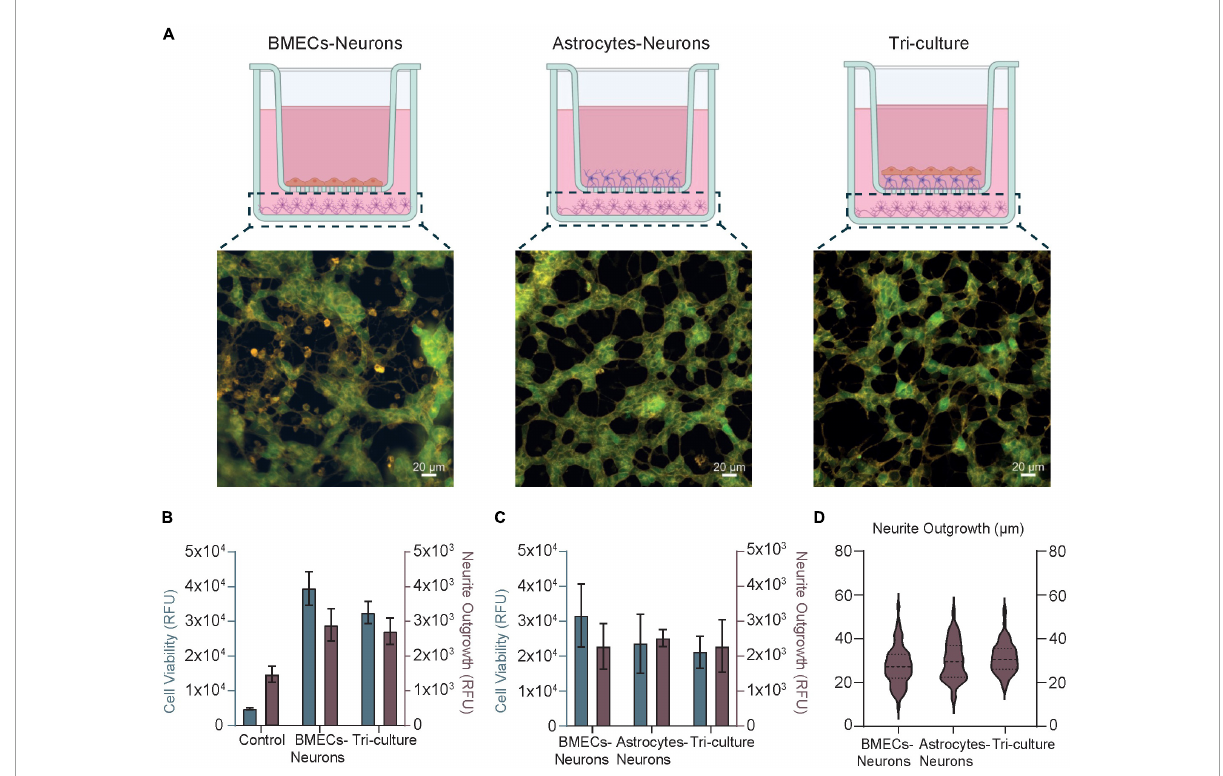
FIGURE4 (A) Schematics and fluorescence images of SH-SY5Y cells representative of the neural compartment in the BMEC-neuron culture (left), astrocyte-neuron co-culture (center), and tri-culture (right) models at day 10 of cell culture. Created with www.biorender.com.. Cells were loaded with fluorescent dyes (Kaur et al., 2012) enabling a real-time visualization of neurons viability (green) and their neurites (orange) in the samples. (B,C) Bar Charts obtained upon fluorescence quantification of cell viability (gray) and neurite outgrowth (brown), both in arbitrary units (RFU). Control stands for cell-free samples loaded with the fluorescent dyes. (D) Box violin plots describing neurite outgrowth quantification ( µ m) obtained upon image analysis. Dash lines represent the median, and the dotted lines represent the 75 and 25% of the data distribution,